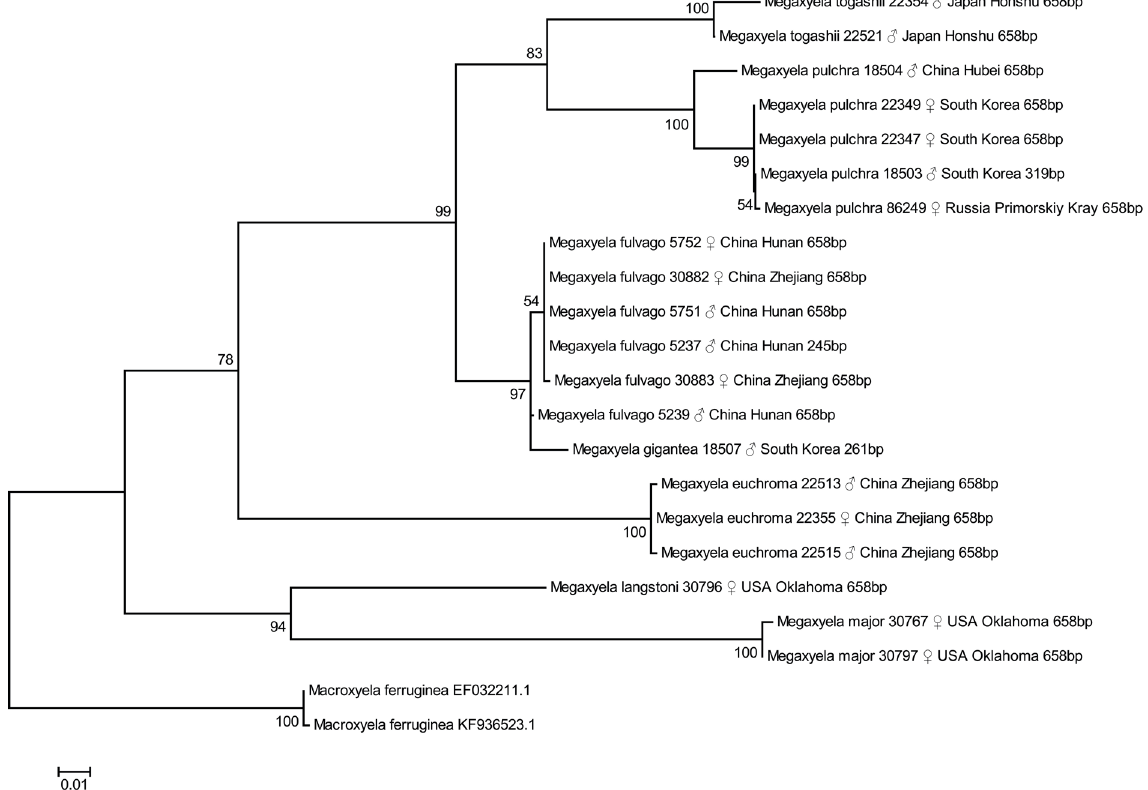
Fig. 2. Phylogenetic hypothesis of Megaxyela Ashmead, 1898, based on a Maximum Likelihood analysis of the barcoding region (COI-5P) applying the the Jukes-Cantor model. Two specimens of Macroxyela ferruginea (Say, 1824) have been included as outgroup. See Material and Methods for details. Bootstrap values above 50 % are shown next to the concerning nodes. The labels of the individual specimens consist of species name, voucher number (for Megaxyela identical with the DEI-GISHym numbers used in the text, for Macroxyela GenBank accession number), sex (♀ for females, ♂ for males) or larva, country and province of origin, and sequence